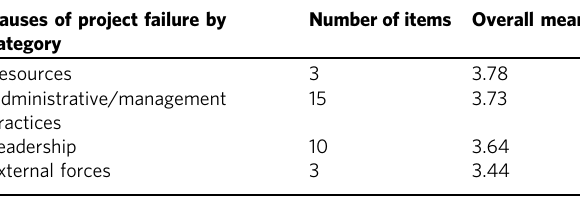
Table 2 Causes of project failure by category ( N =